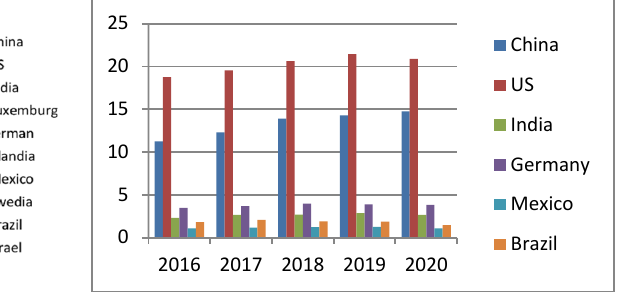
Fig. 1. Largest foreign direct investment (FDI) inflow from Fig. 2. Gross domestic product (GDP) 6 out of the 10 largest FDI recipient countries by OECD (2016-2020